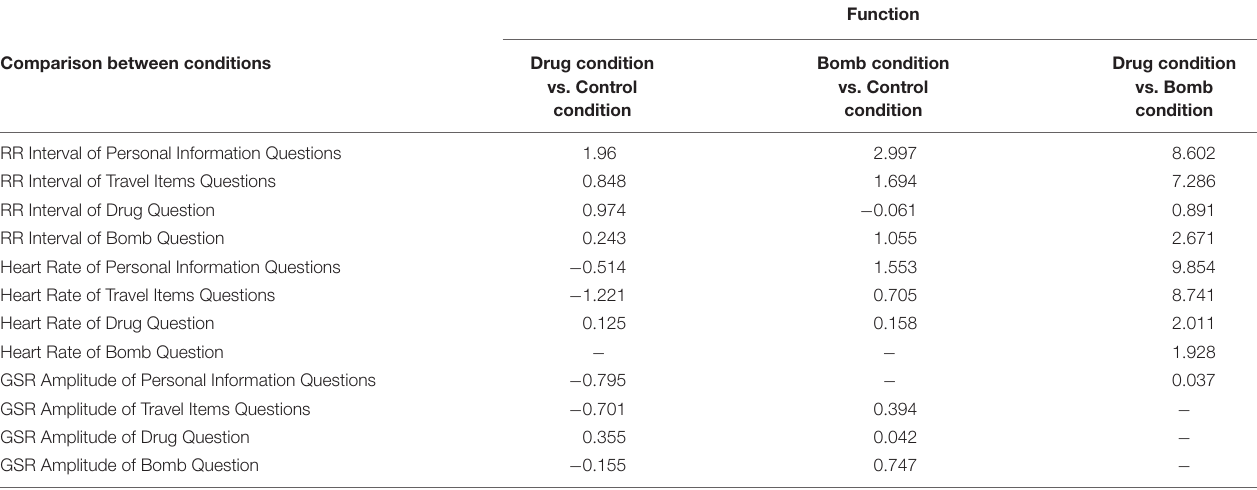
TABLE 4 | Standardized canonical discriminant function coefficients in Experiment